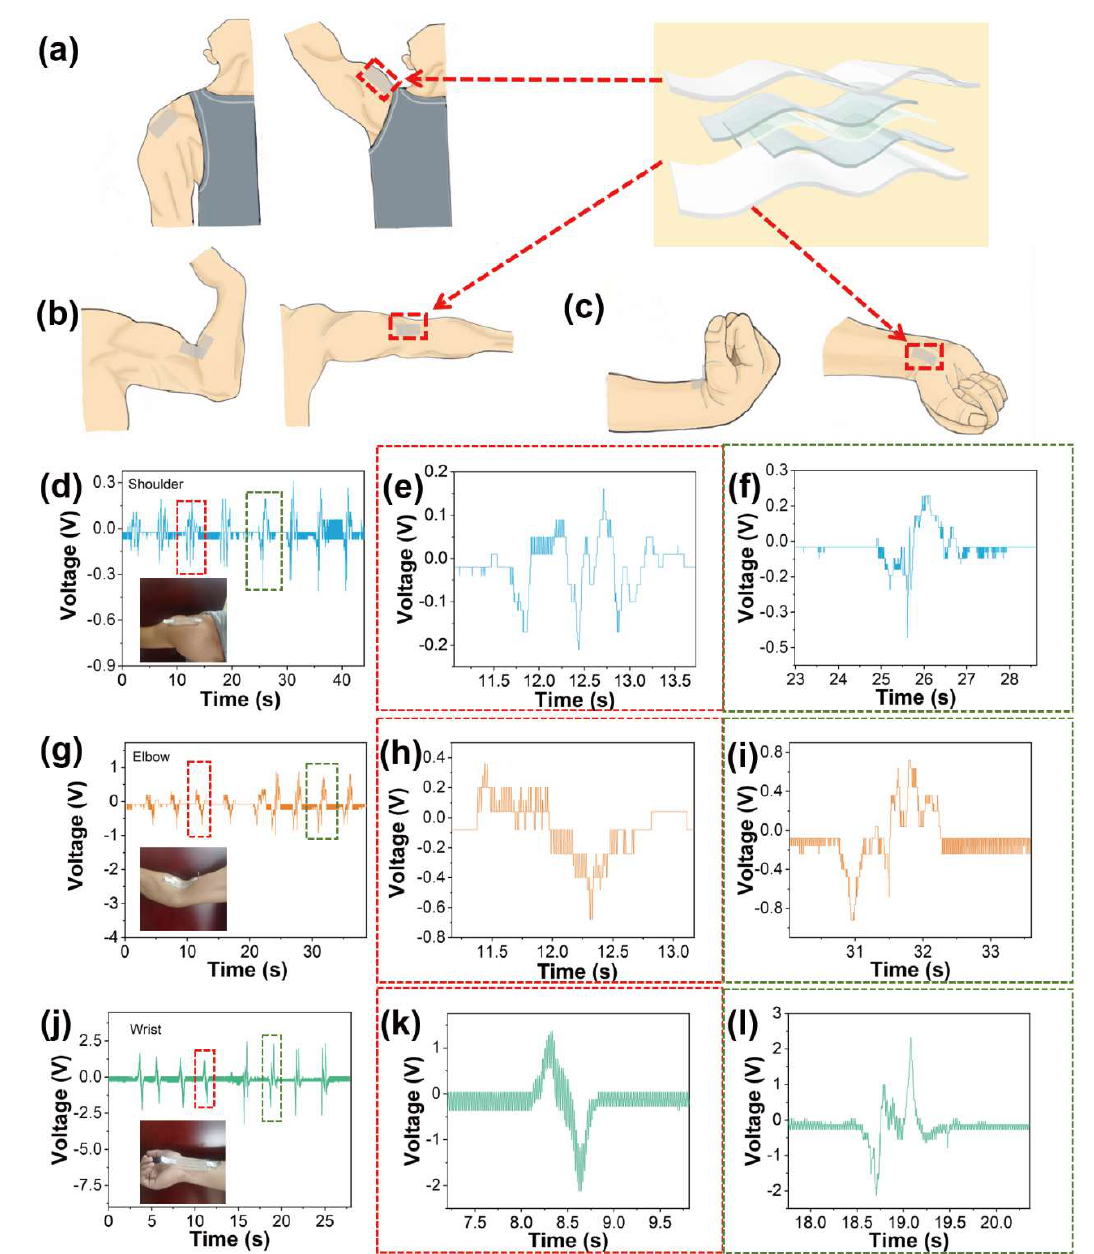
Figure 4. ( a – c ) Scenes of the working mechanism of TSB-PENG is fixed on the shoulder, elbow, and chest. ( d ) Outputting piezoelectric voltage of TSB-PENG on the shoulder that does the bend and stretch motion. ( e , f ) Enlarged drawings of bend and stretch motion of the shoulder. ( g ) Enlarged drawing of outputting piezoelectric voltage of TSB-PENG is fixed on the elbow which protrudes, bend and stretch. ( h , i ) Enlarged drawings of the elbow that does protrusion and bend-stretch movements. ( j ) Outputting piezoelectric voltage of TSB-PENG is fixed on the wrist that protrudes, bends, and stretches. ( k , l ) Enlarged drawings of the wrist in a protruding and bend stretch motion.